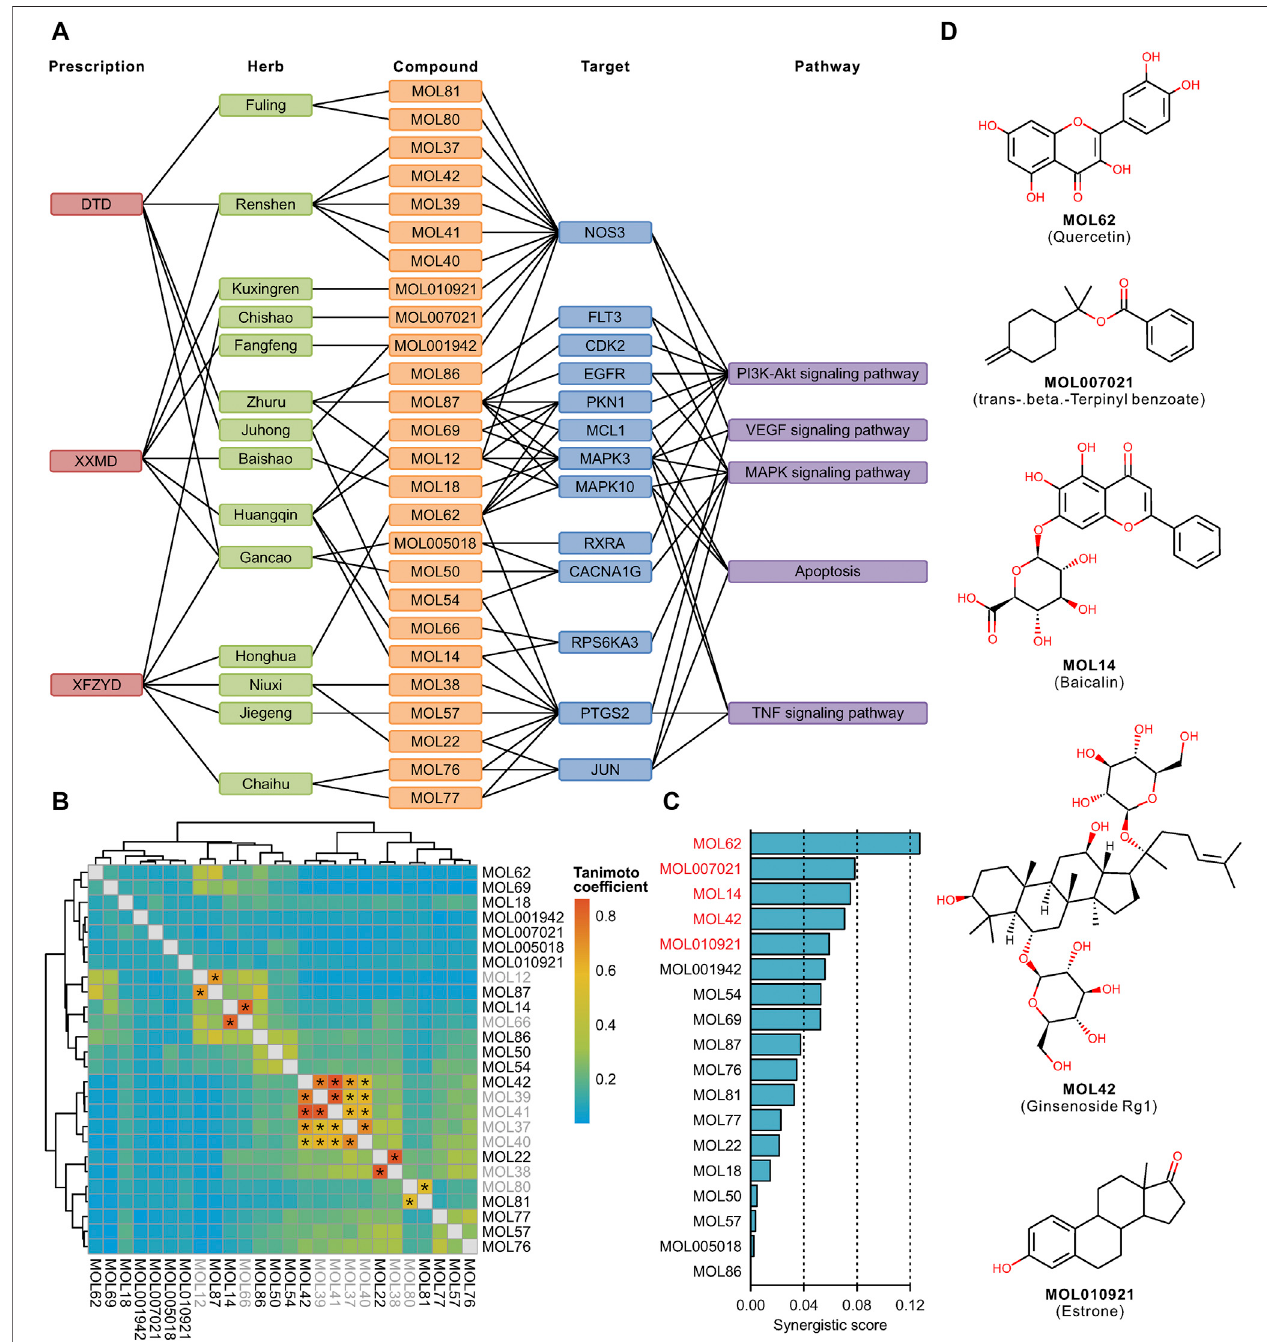
FIGURE 6 | Screening of key compounds by calculating the synergistic score: Network relationship of prescription, herb, compound, target, and pathway (A) . Molecular fi ngerprint similarity of the screened compounds. Compound pairs with similarity > 0.5 are marked with an asterisk. Gray color indicates the removed compound (B) . Synergistic score of the fi ltered compounds. The top 5 compounds are shown in red (C) . Chemical structure of the top 5 compounds (D) .